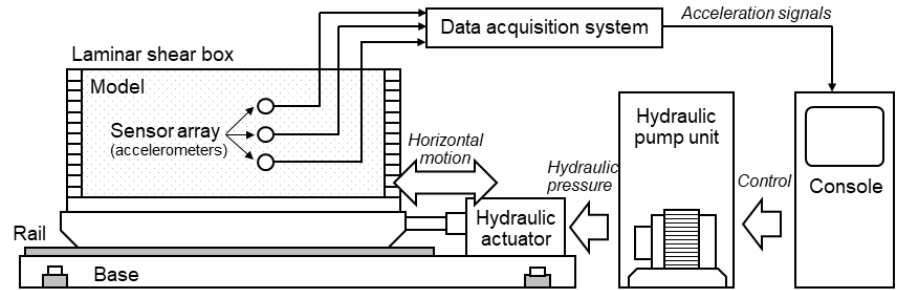
Figure 1. The experimental system used in this study (Kim et al. [13]).